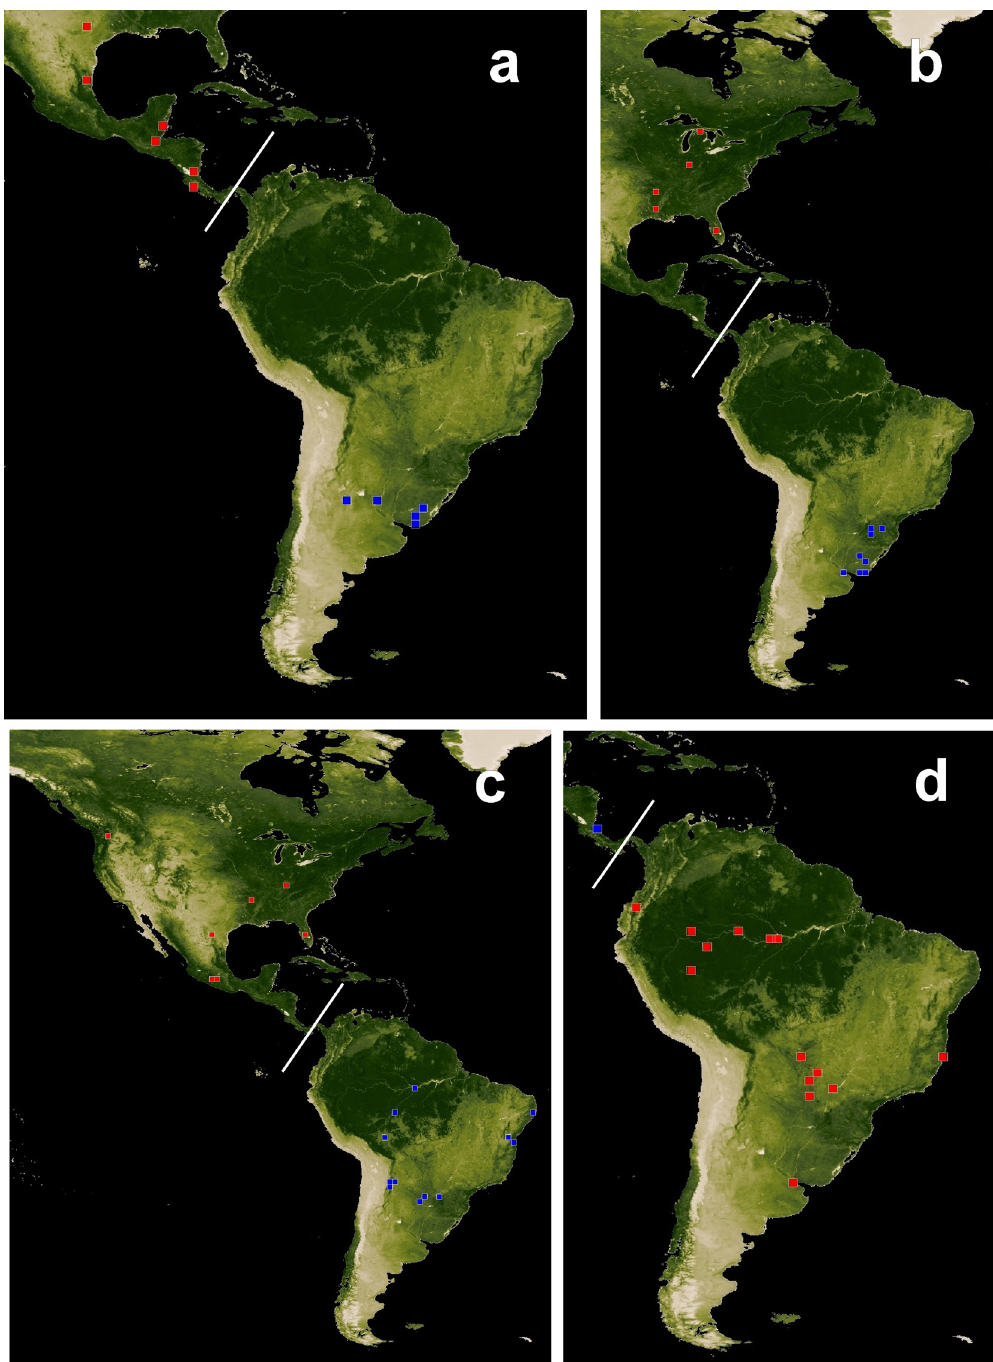
Figure 3 - SVe3 (Supported Vicariant event 3): (a) Farrodes texanus (red) vs F. maculatus (blue); (b) Callibaetis willineri (blue) vs C. pretiosus (red); (c) Callibaetis floridanus (red) vs C. gonzalezi (blue); (d) Tortopus bellus (blue) vs rest of the genus (red). White lines are for visual reference (they are located in the same place in all the